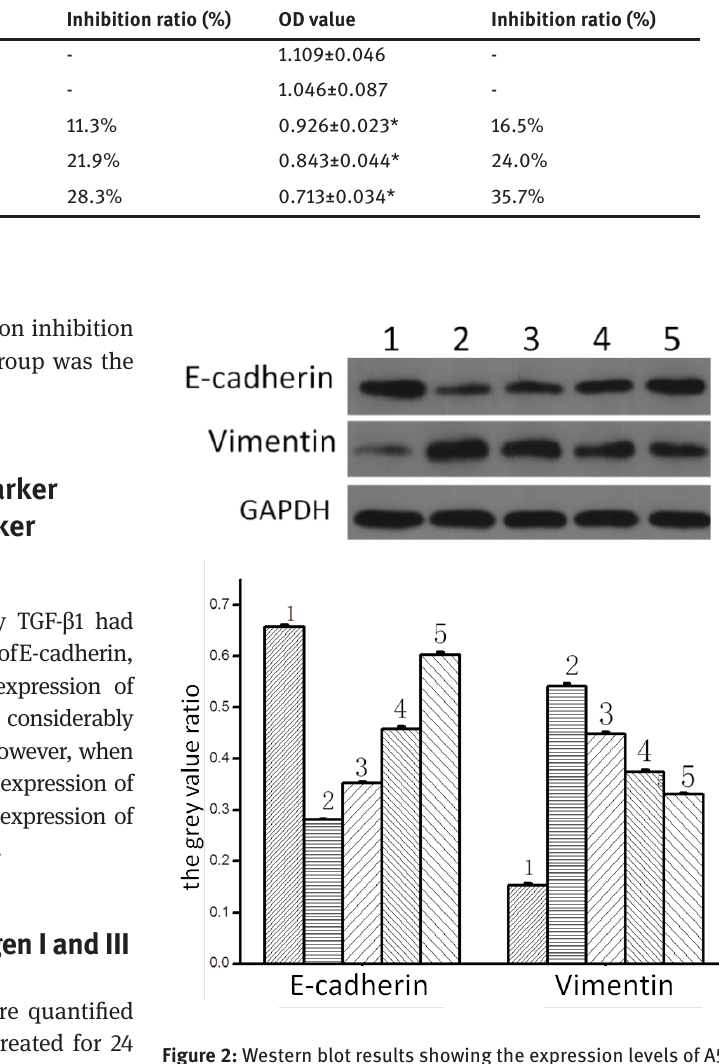
Table 1: Inhibitory effects of different concentrations of GLXB-D drug serum on A549 induced by TGF-β1（n=3,（x±s（. Groups 24h